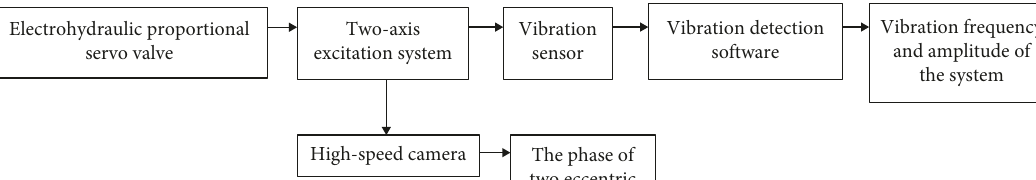
Figure 5: Test process.